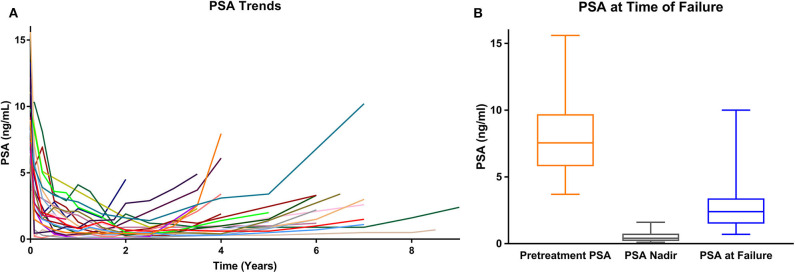
(A) PSA values over time for each isolated local failure. (B) PSA values at time of failure (whisker box plot).